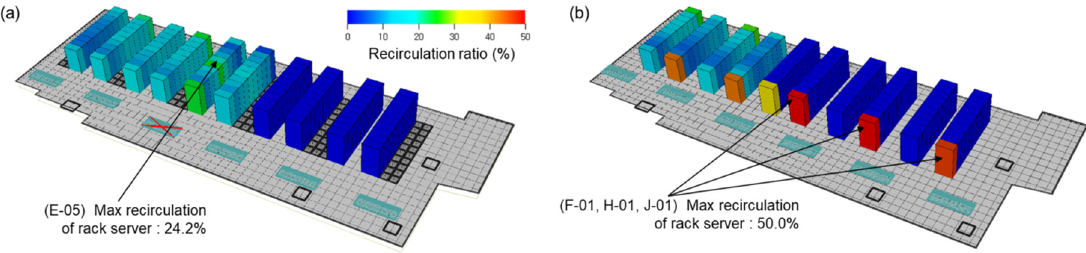
Figure 16. The recirculation ratio of 100 server racks in cooling fault condition; ( a ) ALT-3: HAC raised floor and ( b ) ALT-4: HAC hard floor.